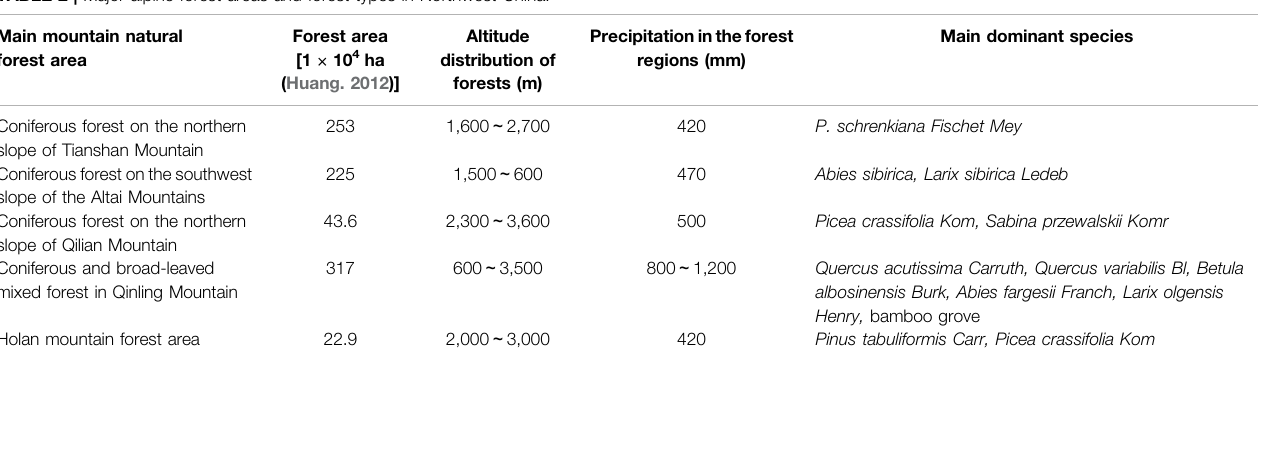
TABLE 2 | Major alpine forest areas and forest types in Northwest